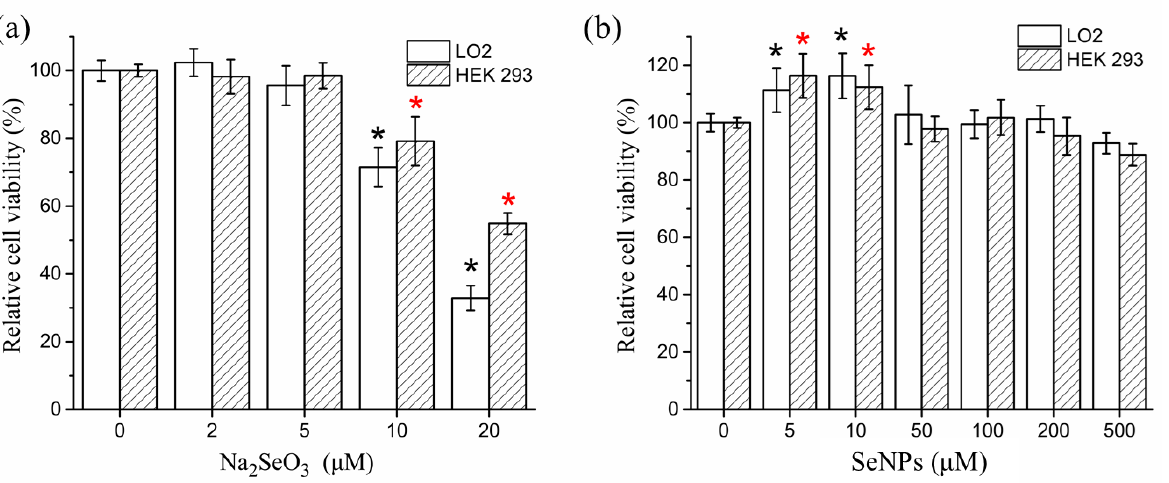
Figure 3. Cytotoxicity of ( a ) Na 2 SeO 3 and ( b ) SeNPs in LO2 cells and HEK 293 cells. The results are expressed as means ± SD. * p < 0.05 versus control.